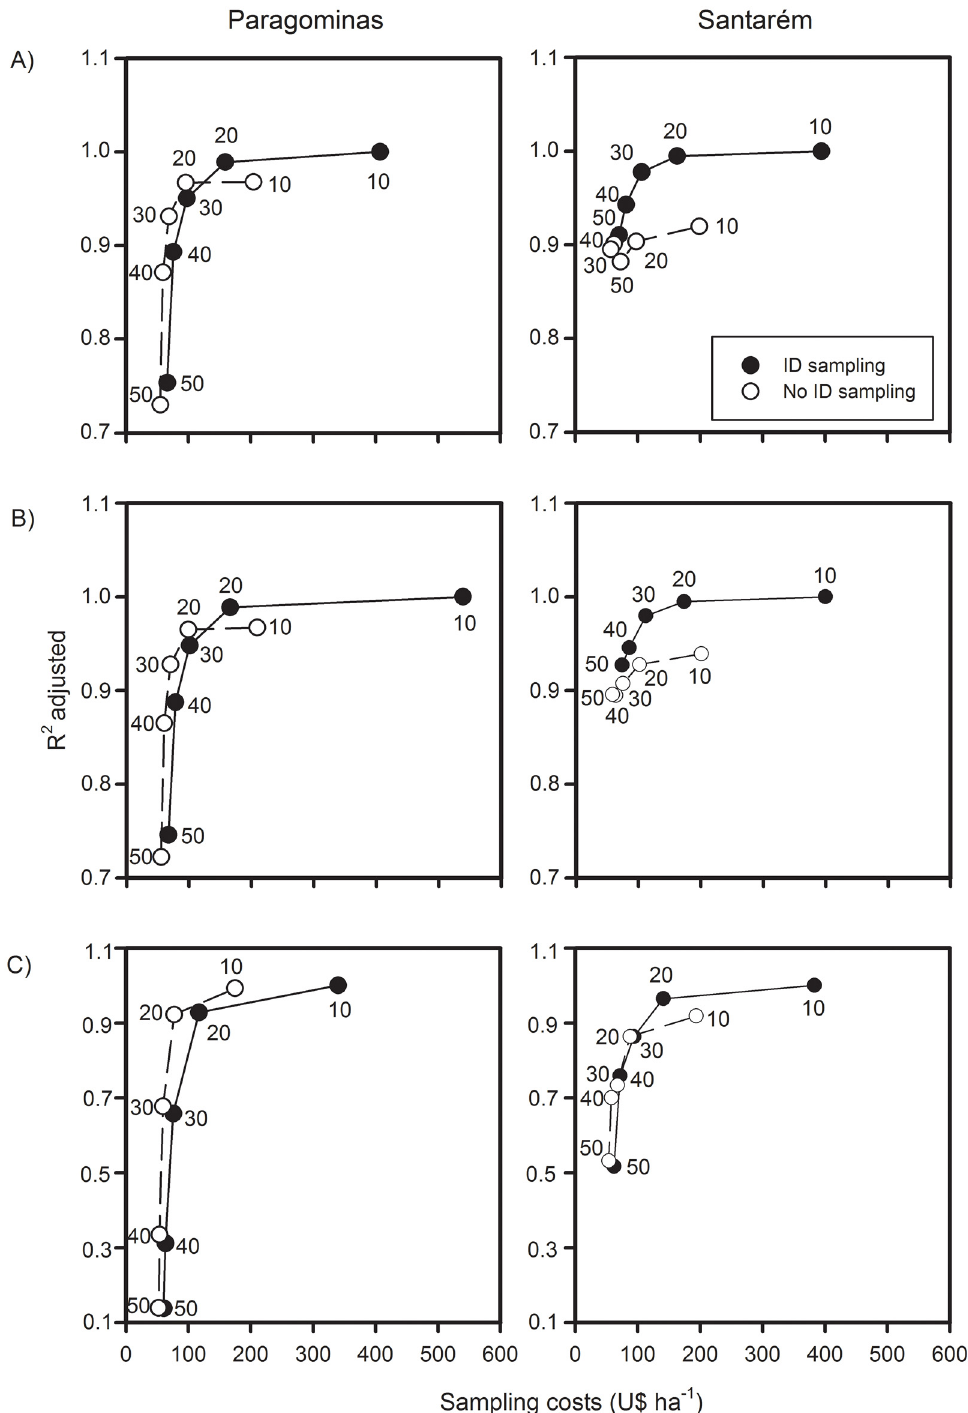
Fig 5. Predicting if a forest is carbon-rich or carbon-poor. Relationship between the coefficient of determination (R 2 ) of different subsets of large live stems and the costs of sampling a 1-ha plot. Results are separated into three hypothetical scenarios of carbon stock assessments in human-modified tropical forests: A) No a priori information of forest class; B) Primary forests only — includes undisturbed and disturbed primary forests; and C) Secondary forests only. The coefficient of determination was obtained through linear models applied to calculate the power of each subset of stems to predict the carbon stocks present in our best measure of large stems stocks (all stems (cid:1) 10cm DBH identified to species level).